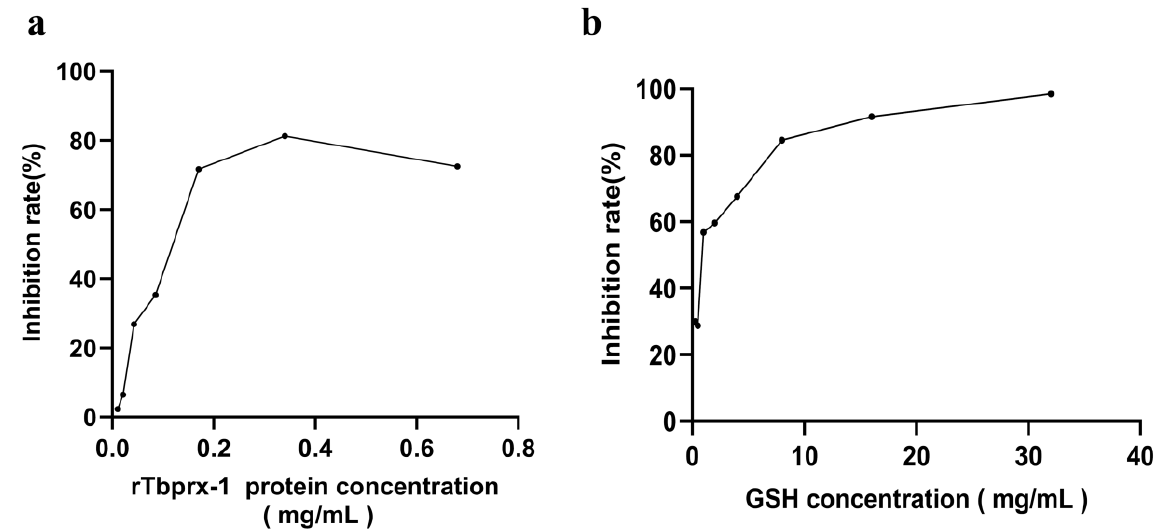
Figure 4. Comparison of hydroxyl free radical scavenging abilities of rTbprx-1 and glutathione (GSH). ( a ) Hydroxyl free radical scavenging ability of the rTbprx-1 expression product. ( b ) Hydroxyl free radical scavenging ability of GSH.